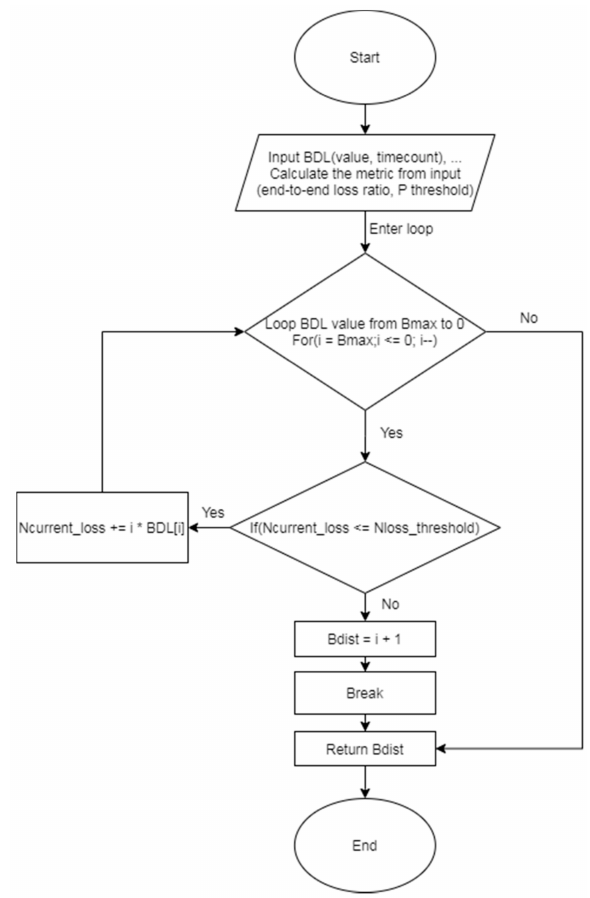
Figure 4. The flowchart of the main procedures in Algorithm 2.